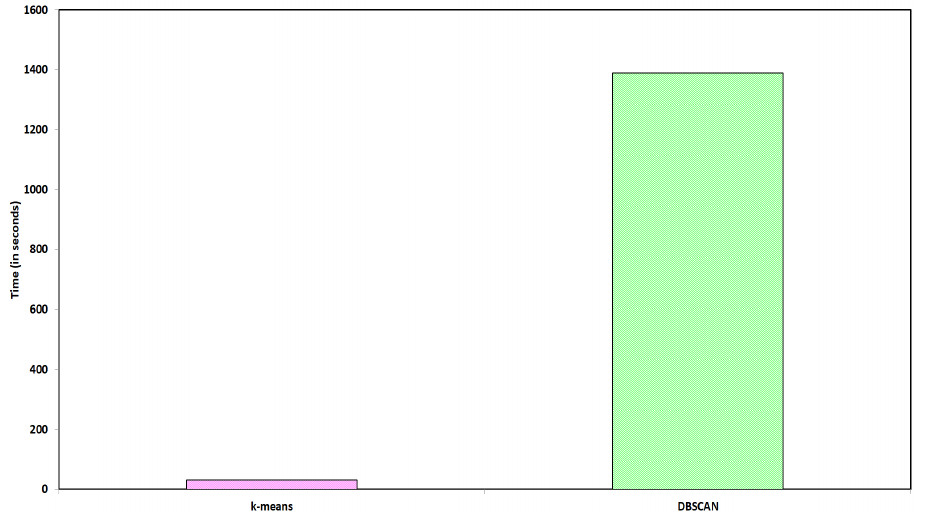
Figure 21. Execution time for the different operations performed in case studies 1 and 2.